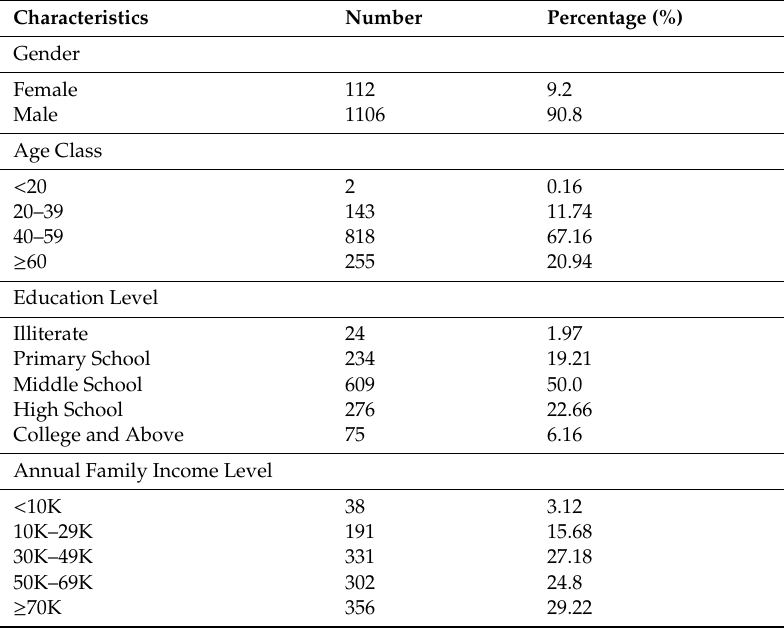
Table 4. Summary statistics of the local farmers.